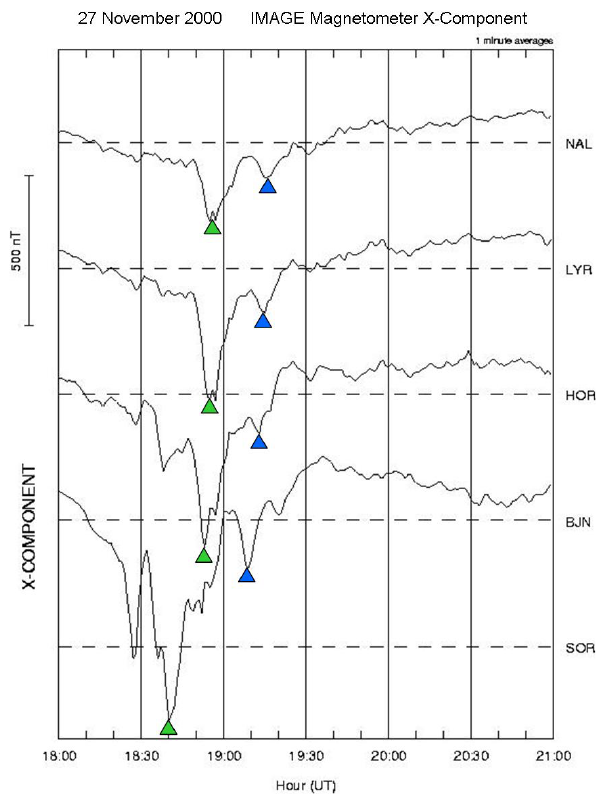
Fig. 6. Magnetogram for the X-component at 5 different sta- tions from 18:00–21:00UT: Sørøya (SOR, 67.34 ◦ N), Bjørnøya (BJN, 71.43 ◦ N), Hornsund (HOR, 74.12 ◦ N), Longyearbyen (LYR, 75.23 ◦ N) and Ny ˚Alesund (NAL, 76.17 ◦ N). All latitudes are given in Corrected GeoMagnetic (CGM) coordinates from the year 2000. The green and blue triangles correspond to a substorm onset and the apparent subsequent poleward expansion,